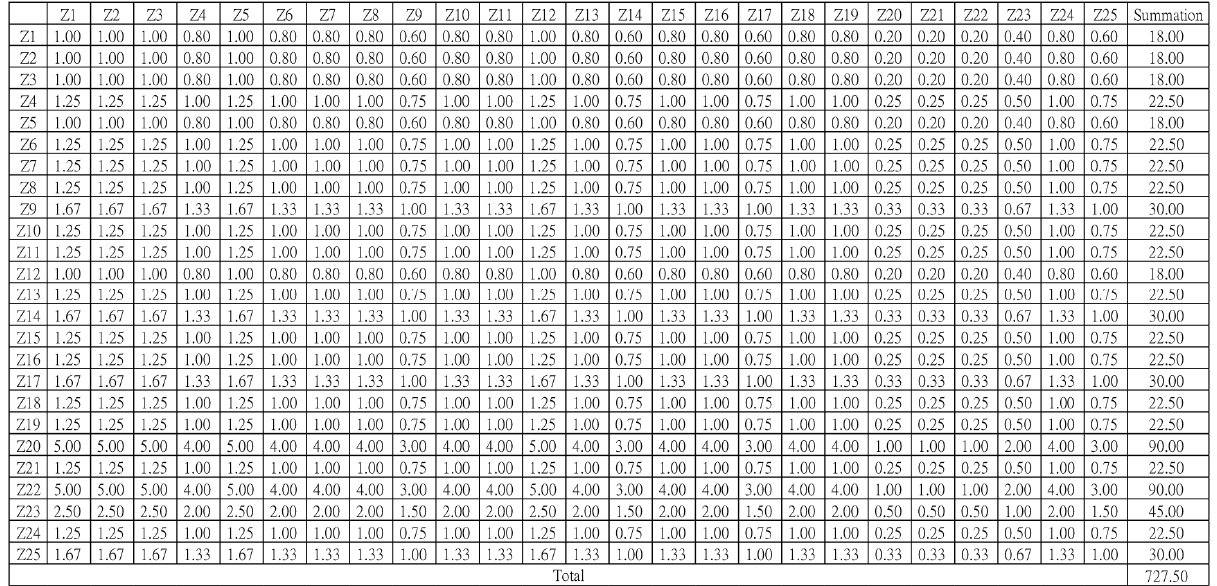
Table 3. Subjective incidence matrix of the first decision-making